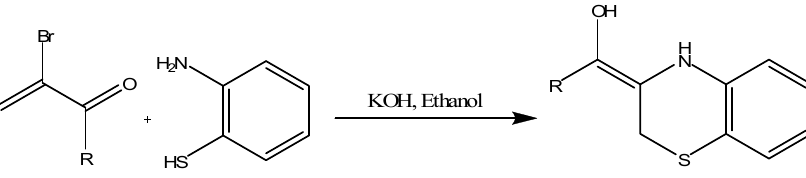
Scheme 14. Synthesis of 1,4-thiazine derivatives from α -bromopropenone derivative and 2-amino- thiophenol in ethanolic potassium hydroxide solution [28].